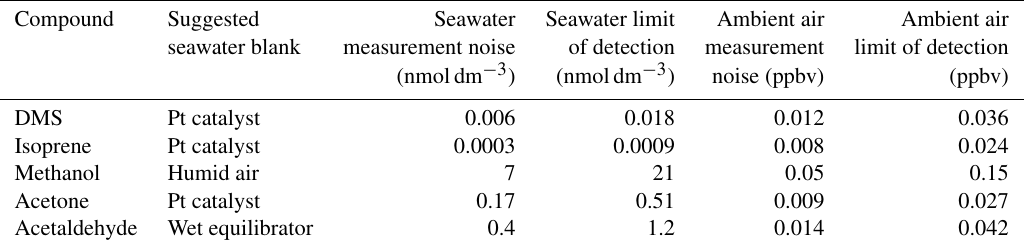
Table 1. Seawater blank used for each compound during this deployment. Hourly measurement noise (1 σ ) and limit of detection (3 σ ) of seawater and ambient air measurement are listed and were determined as described in the